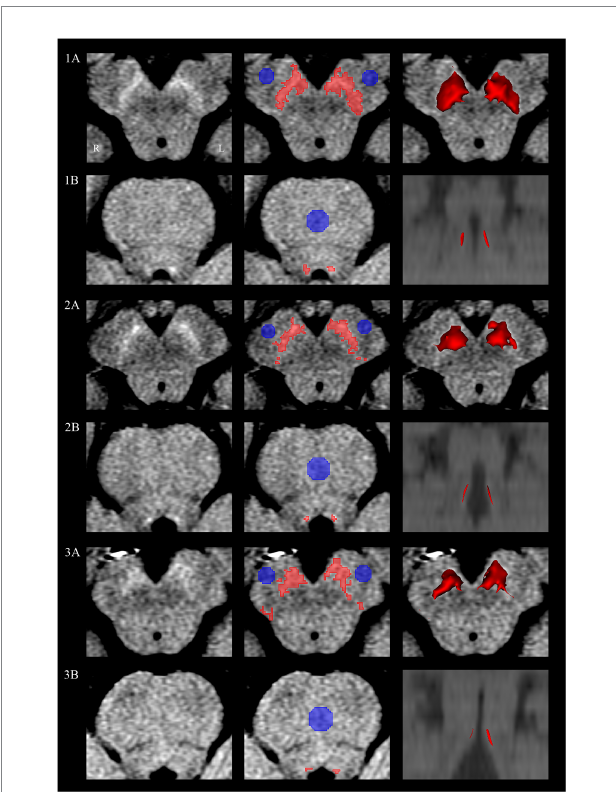
FIGURE 1 Semiautomated interactively segmented regions of interest on neuromelanin MRI. Substantia nigra and locus coeruleus of a HC subject ( 1A , 1B ), PD-NFOG patient ( 2A , 2B ) and PD-FOG patient ( 3A , 3B ). Neuromelanin MRI images of the substantia nigra and locus coeruleus (first column). Regions of interest of substantia nigra and locus coeruleus detected in the semiautomated segmentation shown in red, background reference regions of interest of cerebral peduncle and pontine shown in blue (second column). Three-dimensional surface rendering corresponding to semiautomated segmentation of the bilateral substantia nigra and locus coeruleus (third column). L, left; MRI, magnetic resonance imaging; R,